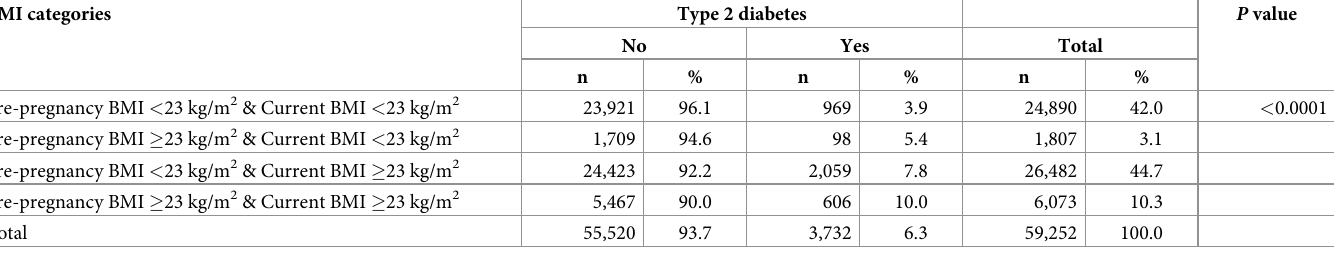
Table 4. Distributions of pre-pregnancy BMI and current BMI categories according to the status of type 2 diabetes in the Health Examinee Study (HEXA) 2004– 2013. BMI